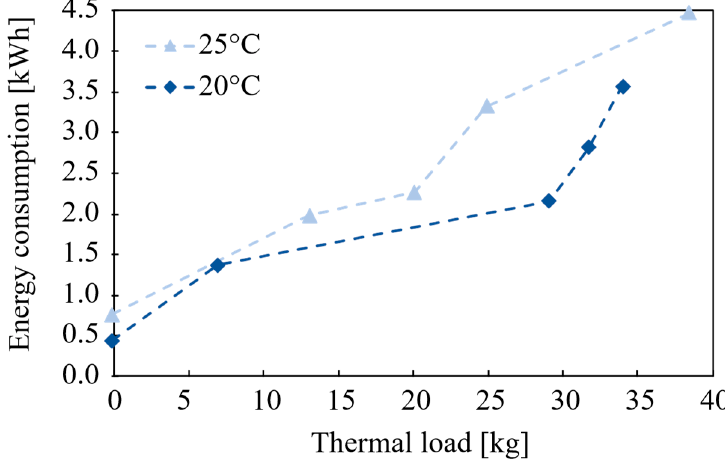
Figure 5. Energy consumption for different thermal loads. Table 3. Energy behavior at different loads and constant ambient